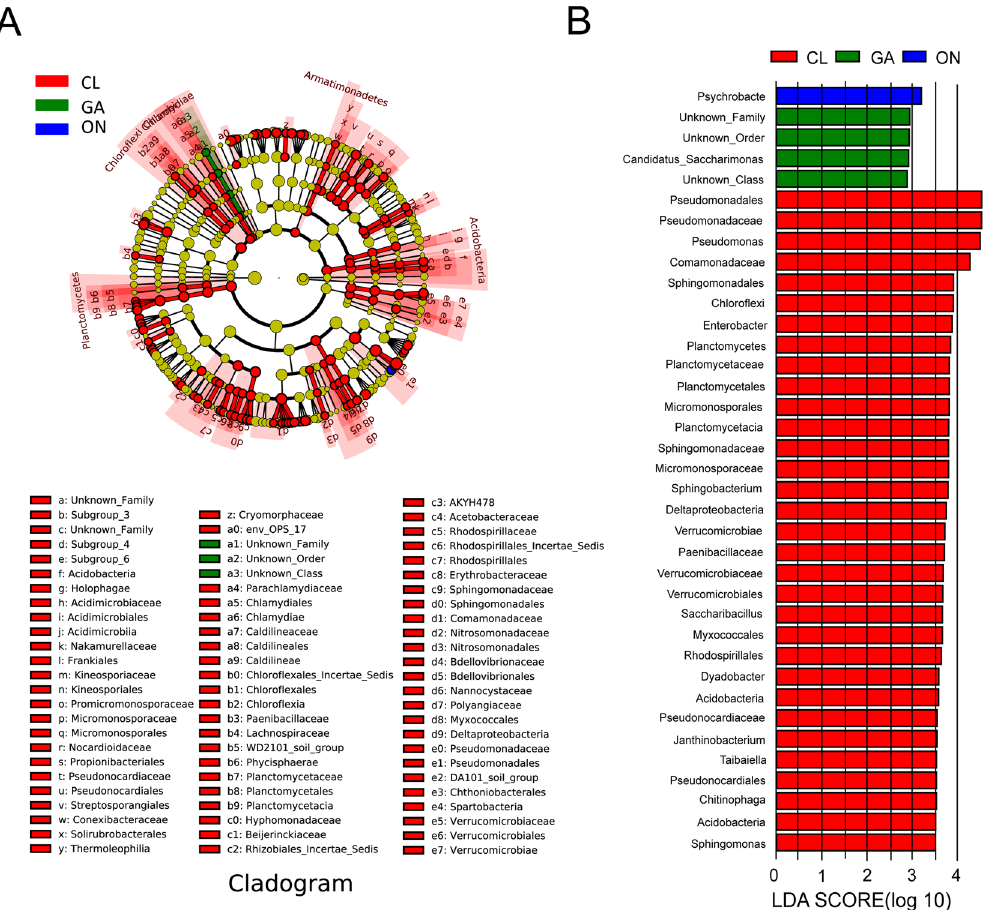
Figure 5. Groups from the phylum-to-genus levels determined to be significant representatives of their sample group, based on LEfSe software analysis. ( A ) Cladogram representing the taxonomic hierarchical structure of the identified habitat biomarkers generated using LEfSe. Each ring represents a taxonomic level, with phylum, class, order, and family emanating from the center to the periphery. Each circle is a taxonomic unit in the dataset, with circles or nodes shown in color where the taxon represents a significantly more abundant group. ( B ) Identified biomarkers ranked by their effect size in different samples. The habitat biomarkers were identified as being significantly abundant (p < 0.05) when compared among samples. CL: Chinese leek; WO: Welsh onion; GA: Garlic; ON: